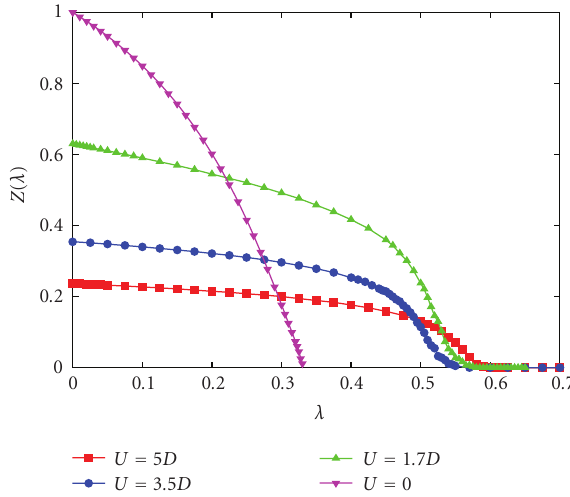
Figure 11: Quasiparticle renormalization as a function of λ for di ff erent values of U and ω 0 = 0 . 0125 W . The value of λ at which polaron formation occurs is only moderately increased by correlations with respect to the noninteracting case (after Sangiovanni et al.